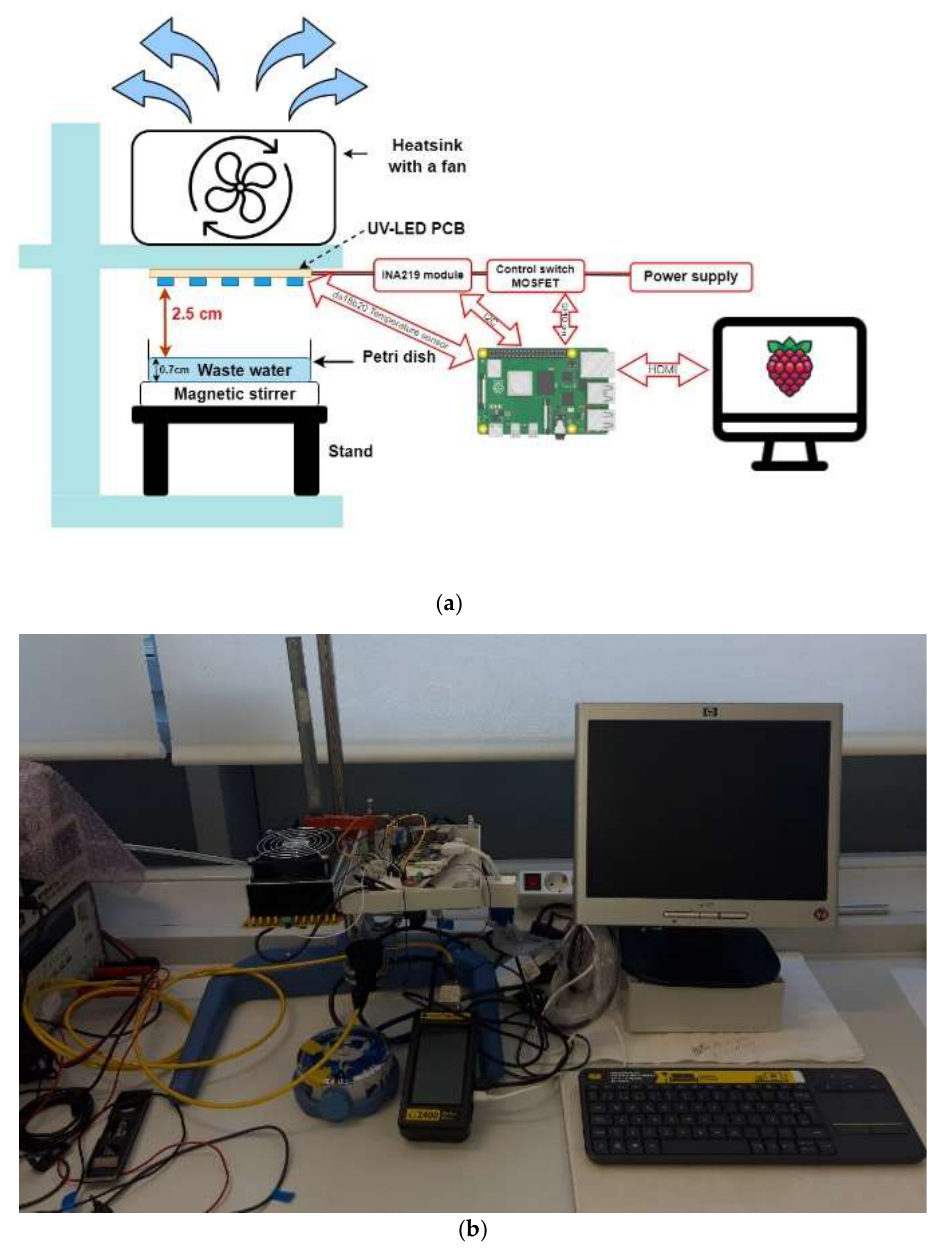
Figure 3. Experiment setup showing (a) the scheme for wastewater exposure to UV-LEDs, and (b) the photograph of actual experimentation.